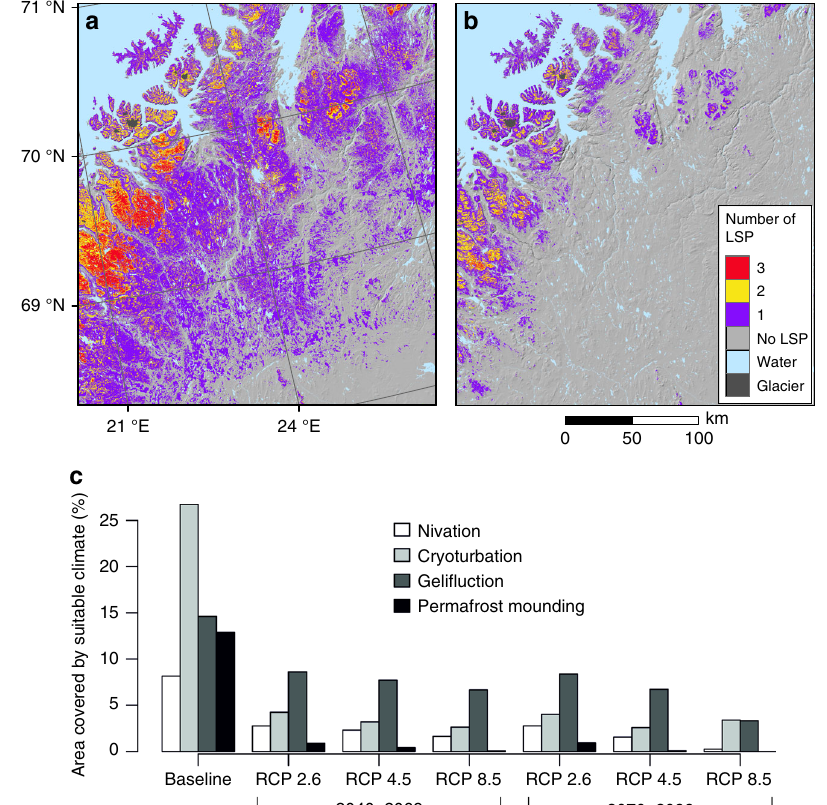
Fig. 5 The predicted loss of conditions allowing cryogenic land surface processes. a , b The suitable overlapping conditions for the land surface processes (LSP) under baseline (i.e., current climate of 1981 – 2010) and future climate (2040 – 2069 RCP 4.5), respectively, while c shows the area covered by suitable climate for individual LSP at each time period and climate change scenario. The current extent of glaciers were masked out from the